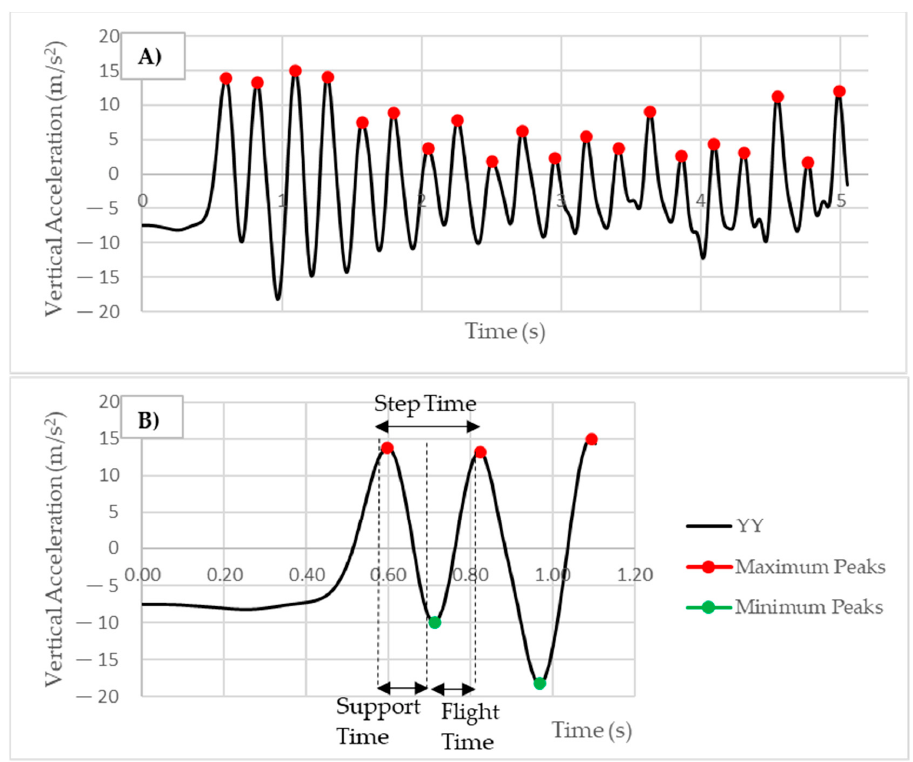
Figure 3. The IMU-obtained vertical acceleration values: ( A ) the identification of the maximum peaks (step numbers); ( B ) the identification of the step time, ground contact time (GCT), and flight time phases.